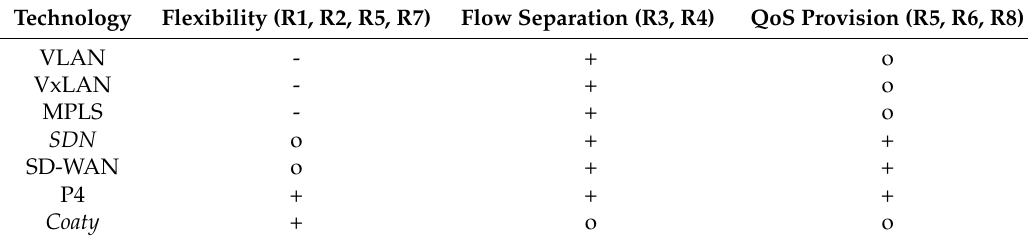
Table 1. Technology